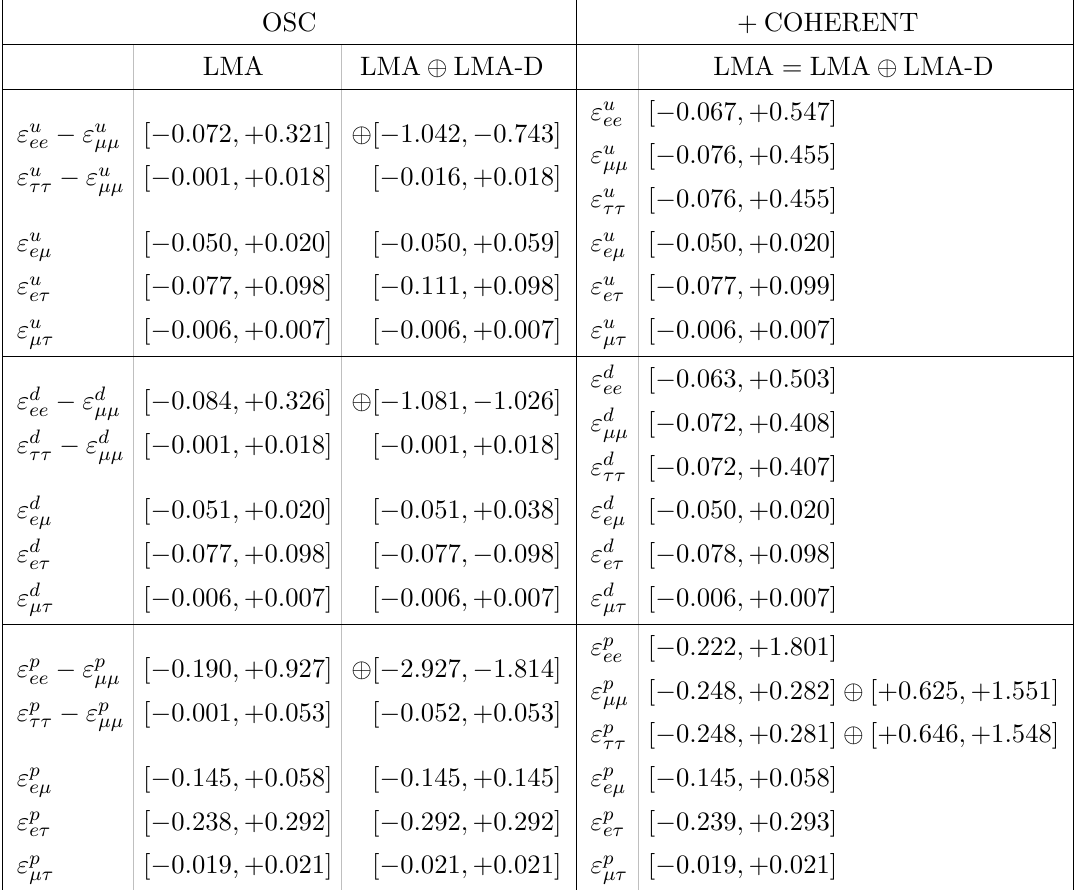
Table 1 . 2 σ allowed ranges for the NSI couplings ε u analysis of oscillation data (left column) and also including COHERENT constraints. The results are obtained after marginalizing over oscillation and the other matter potential parameters either within the LMA only and within both LMA and LMA-D subspaces respectively (this second case is denoted as LMA ⊕ LMA-D). Notice that once COHERENT data are included the two columns become identical in all cases since for NSI couplings to f = u, d, p the LMA-D solution is only allowed above 95%